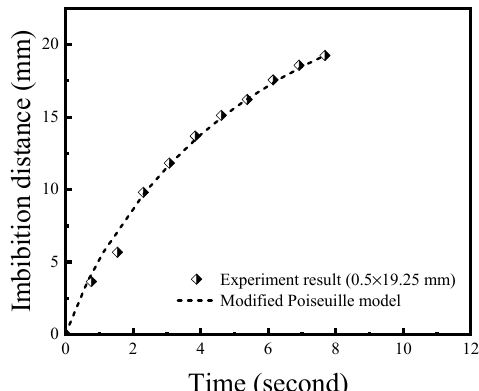
Figure 8. Comparison diagram between the prediction curve of modified Poiseuille model and experimental result in one 0.5 × 19.25 mm single channel. These experiment data are derived from Figure 5a.